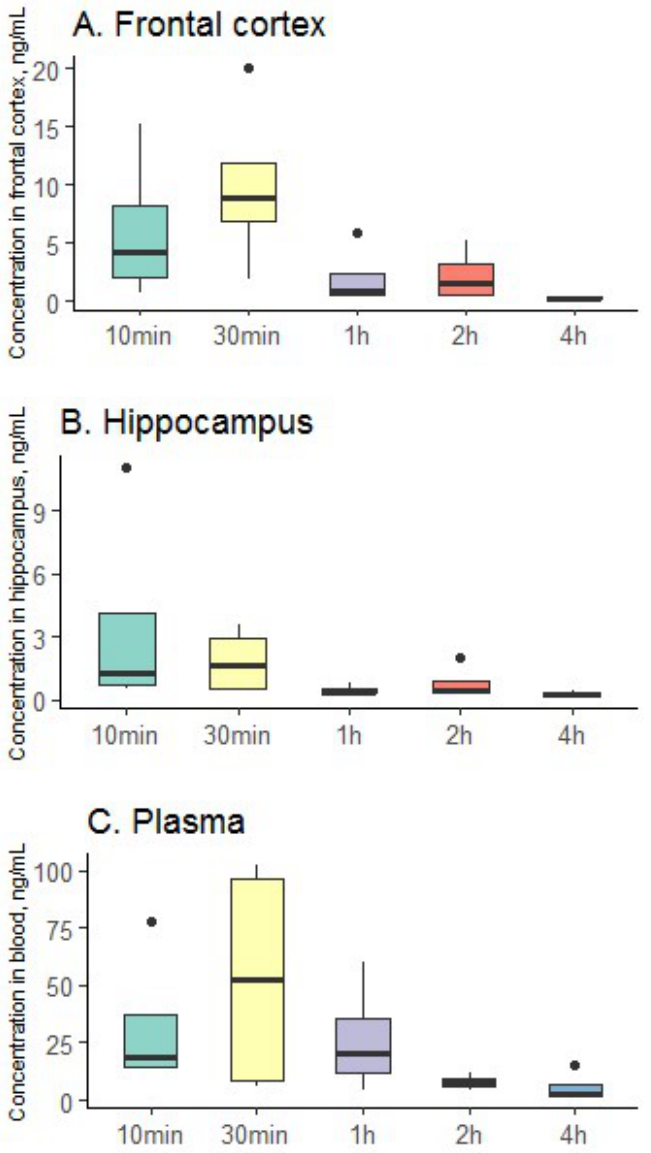
Figure 7. Distribution of clomipramine in brain tissue (( A )—frontal cortex; ( B )—hippocampus and ( C )—plasma); black circles—outliers.